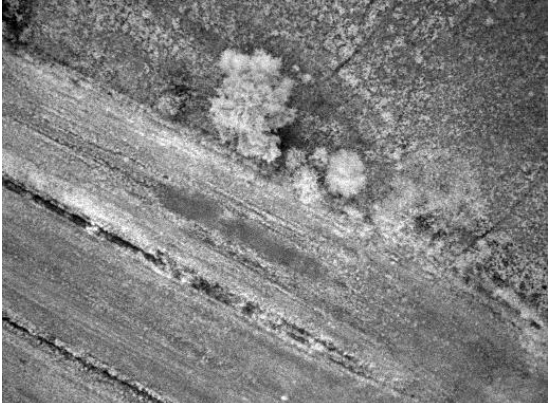
Figure 19 NIR camera view at